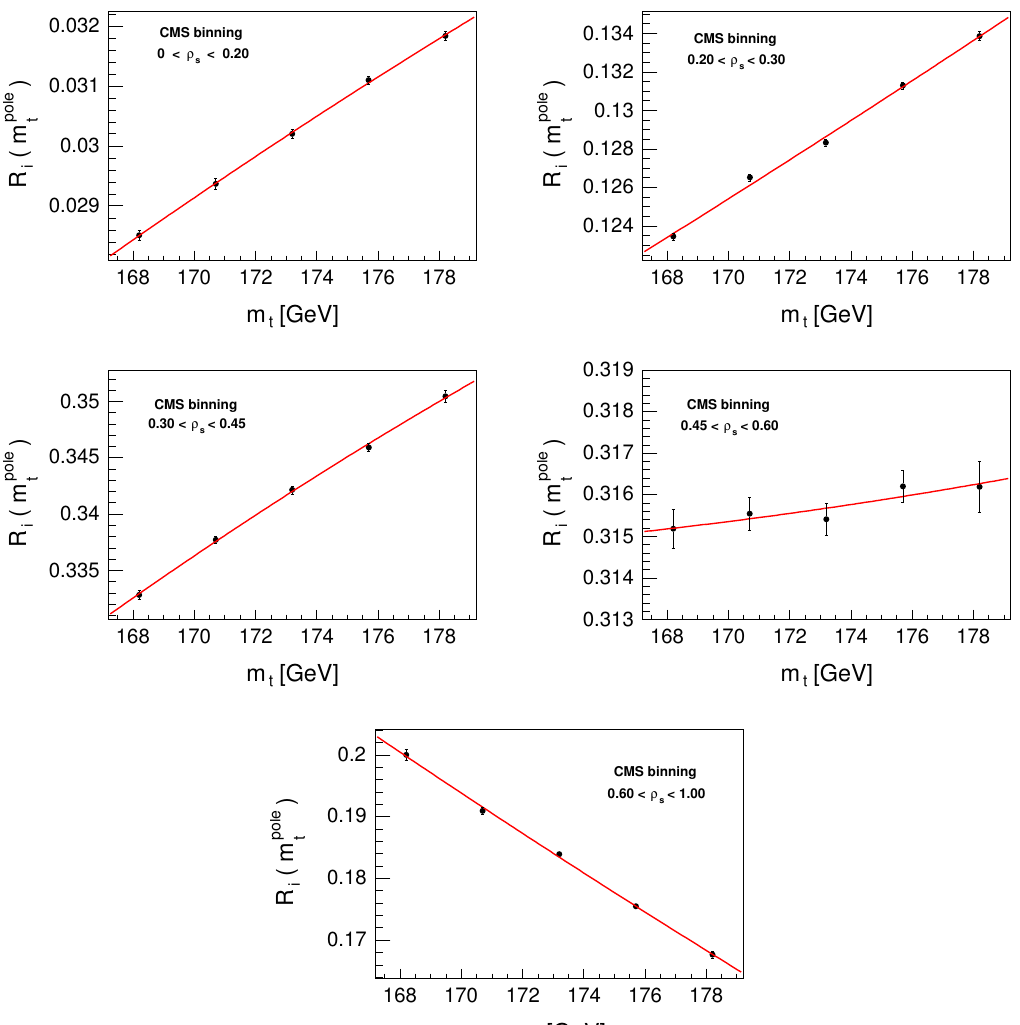
Figure 7 . Bin-by-bin (cid:12)t of template distributions for the normalised (cid:26) s observable as given by full theory at NLO in QCD for the pp e + (cid:23) e (cid:22) (cid:0) (cid:22) (cid:23) (cid:22) b (cid:22) bj + X production process at the LHC with ! p s = 13 TeV. The CT14 PDF set and (cid:22) R = (cid:22) F = (cid:22) 0 = H T = 2 are used. The CMS binning is assumed. The error bars denote statistical